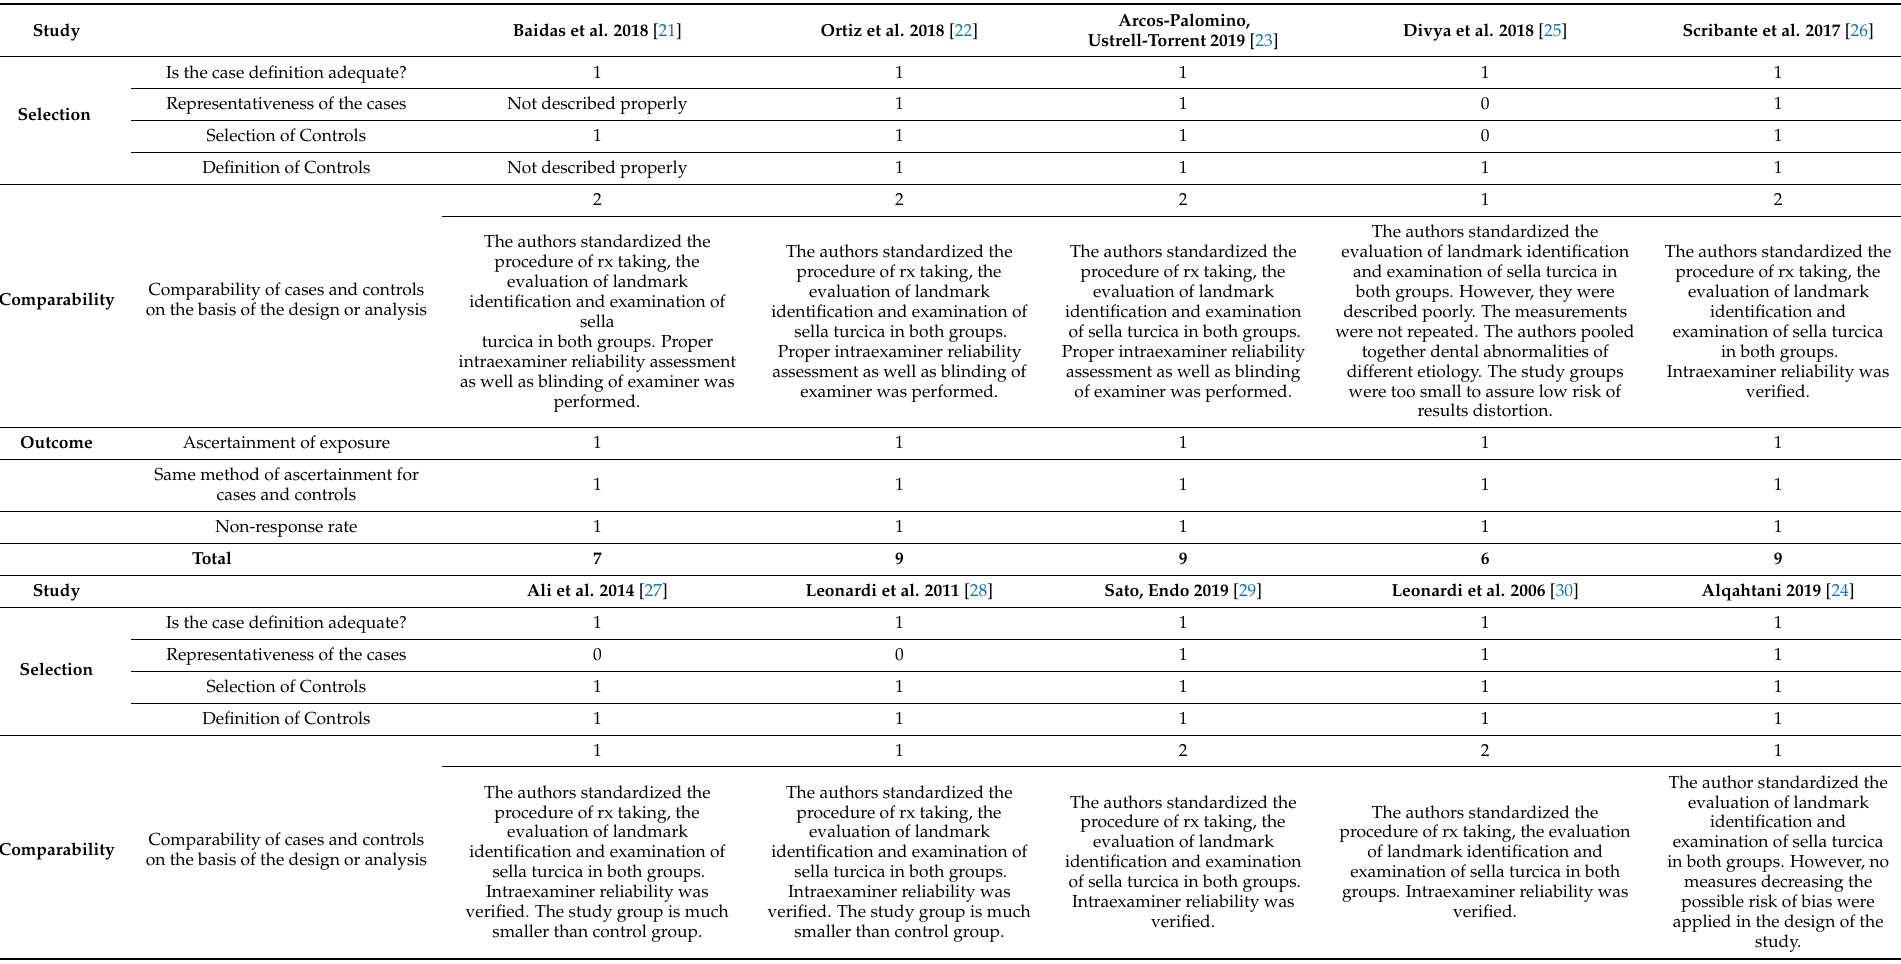
Table 2. Evaluation of case–control studies according to Newcastle–Ottawa quality